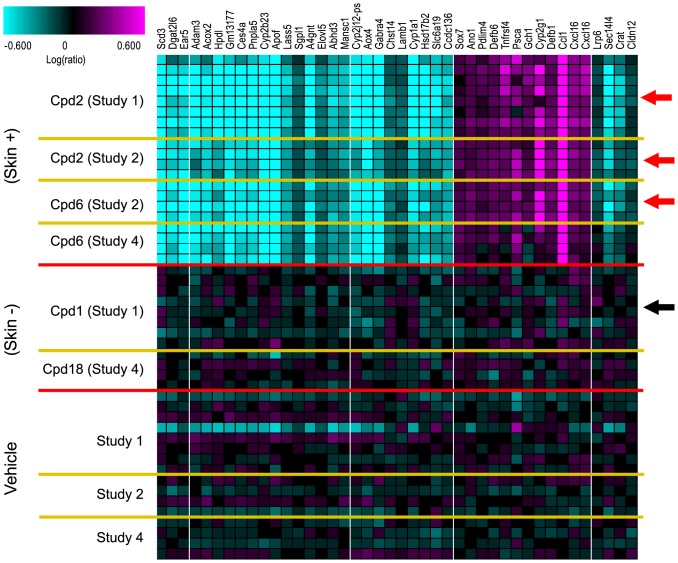
RNA biomarkers for sebaceous gland atrophy in skin.Shown are the 42 probesets, identified in the Training Set (Studies 1 and 2), that were regulated by skin-positive compound treatments (those that produced sebaceous gland atrophy) but not by the skin-negative compound treatments (the one that did not produce sebaceous gland atrophy). After excluding the absent probes (low intensity), these 42 probesets met the following cutoffs: 1.2 fold change and ANOVA p<0.01 between all 3 skin-positive compound treatments (red arrows) and their respective vehicle treatments, and ANOVA p>0.1 between the skin negative compound treatment (black arrow) and its respective vehicle treatment. The probesets for RIKEN genes were excluded. Plotted are the LogRatio values (+/− 4 fold fold scale) with magenta representing up-regulated probesets and cyan representing down-regulated probesets. Treatments from the independent Test Set (Study 4) are included for comparison but were not used to identify the 42 probesets.